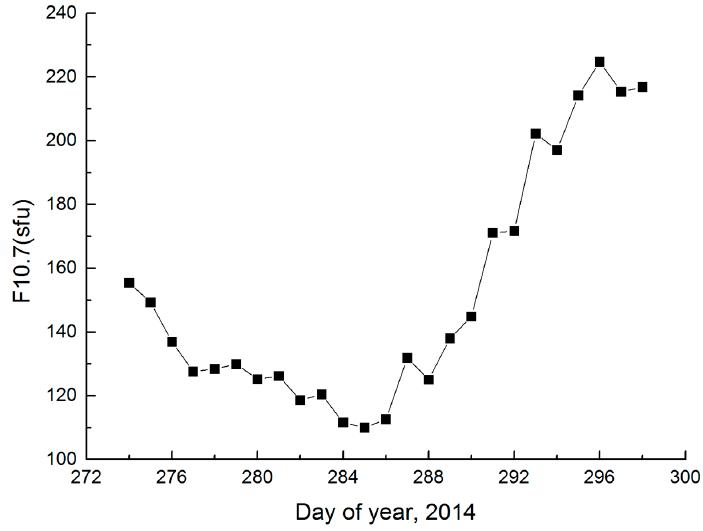
Figure 6. F10.7 values during 1–25 October 2014.